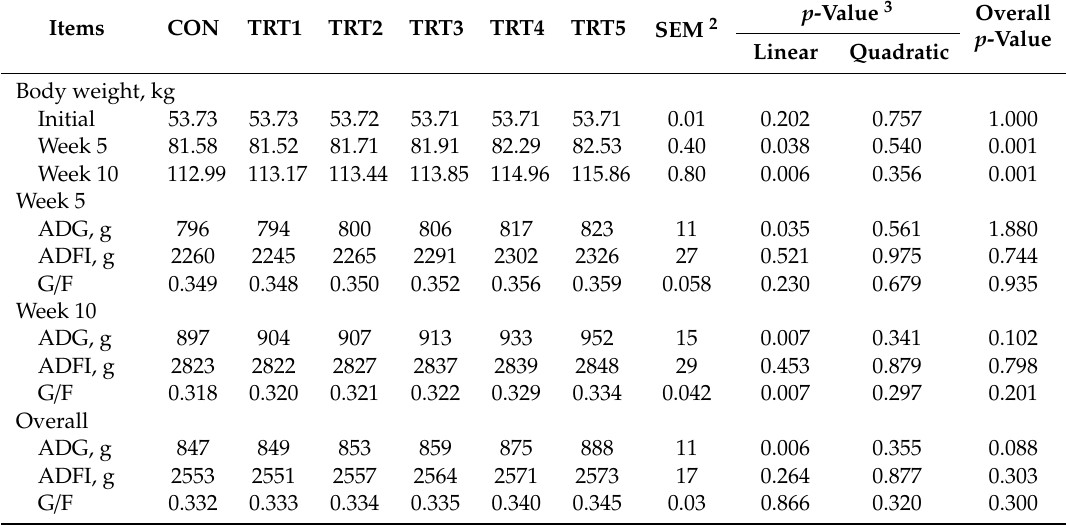
Table 2. The e ff ect of Black pepper supplementation on the growth performance of finishing pigs 1 .